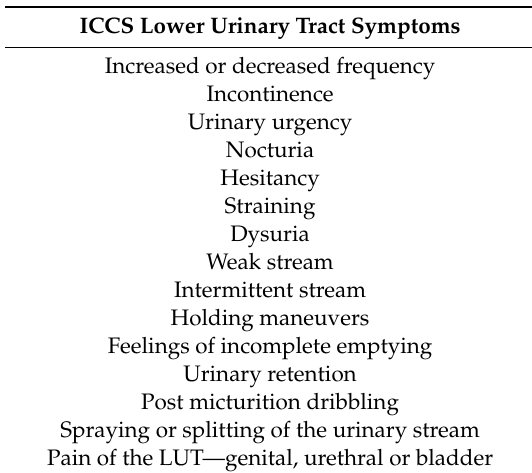
Table 1. ICCS Lower Urinary Tract